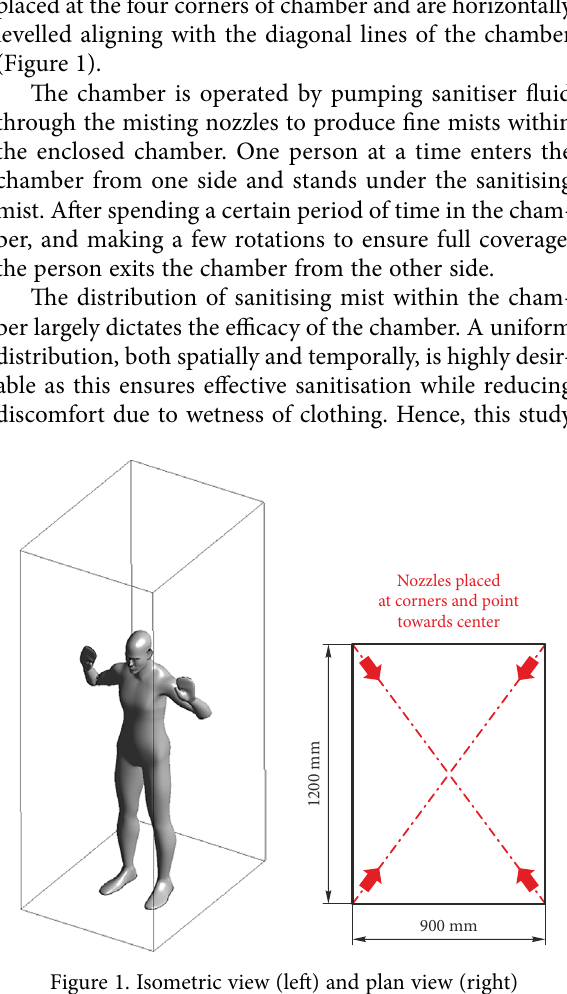
Figure 2. Mediumweight medical garment (180